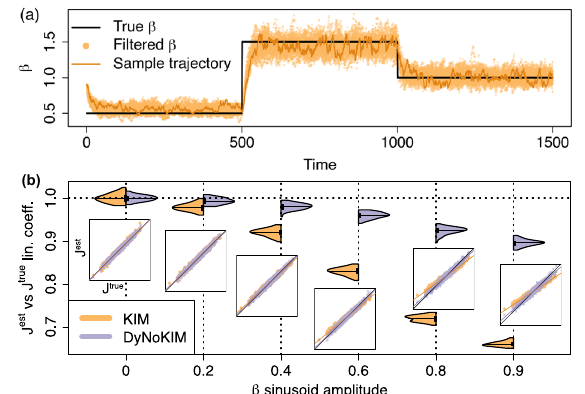
Figure 2. ( a ) Estimation of β from simulated time series of spins, generated with a KIM with piecewise constant β (black line). The β( t ) estimated with the DyNoKIM (yellow dots) over 30 simulations is consistently close to the true value. A sample estimated trajectory is shown in darker color. ( b ) Estimation of J under model misspecification. We simulate 60 time series generated with a KIM and β( t ) = 1 + K sin (ω t ) , ω = 2 π/ 300 , √ T = 3000 , N = 30 , J ij ∼ N ( 0, 1 / N ) , h i = 0 ∀ i , then estimate the DyNoKIM. The main panel shows the distribution of the coefficient of a linear regression between the estimated and true J values, using the KIM and a DyNoKIM. Insets show example scatter plots of the true J values ( x axis) and the estimated values ( y axis) using the standard KIM (yellow points) or the DyNoKIM (purple